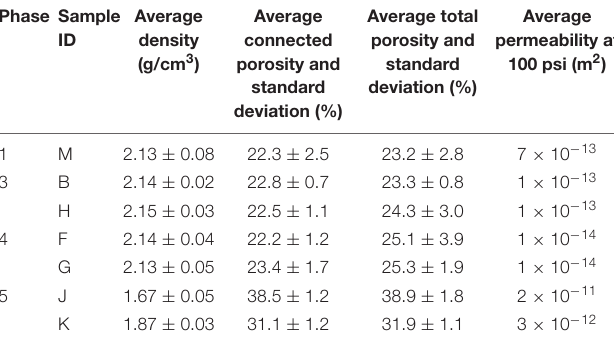
TABLE 3 | Physical properties calculated for each sample, using the following methods: (a) average density, measured using a helium pycnometer and the standard deviation for each block; (b) connected porosity: measured using a helium pycnometer and the standard deviation for each block; (c) total porosity, calculated by measuring the density of a powder and using Equation (1) and the standard deviation for each block; and (d) permeability, measured at 100 psi using the GasPerm